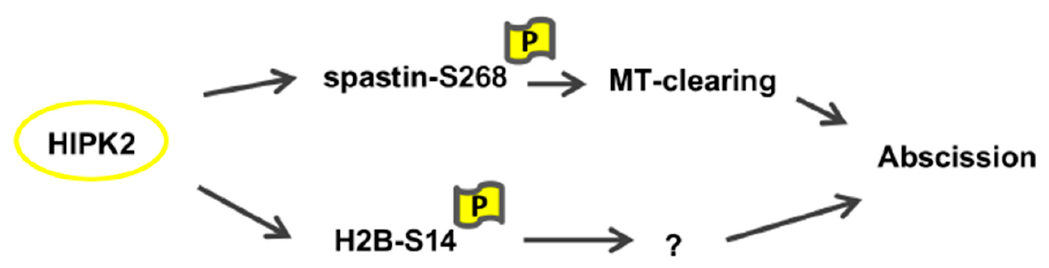
Figure 6. Schematic representation of HIPK2 activity on spastin and H2B during cytokinesis.